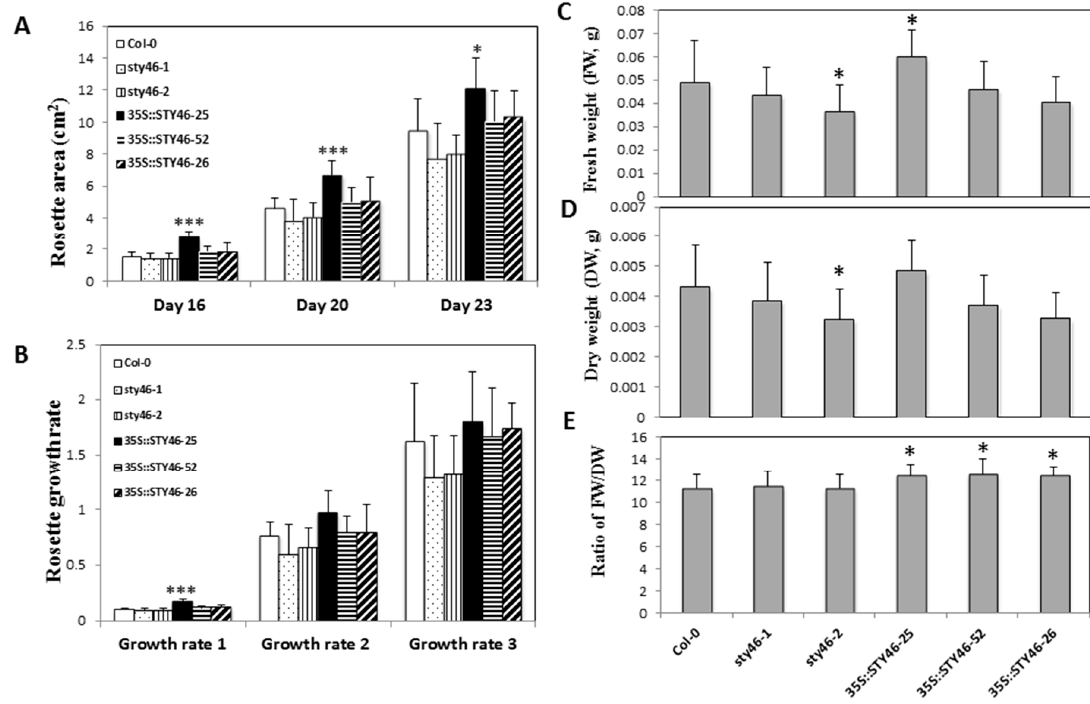
Figure 3. Change in rosette growth parameters. Rosette ( A ) surface area, ( B ) growth rate, ( C ) fresh weight (FW), ( D ) dry weight (DW), and ( E ) FW / DW, of STY46 transgenic genotypes. The rosette area was measured at 16 days, 20 days, and 23 days, respectively, and the growth rate during 0–16 days (growth rate 1), 16–20 days (growth rate 2), and 20–23 days (growth rate 3) was calculated. The asterisks in ( A , B ) indicate the statistically significant di ff erences between transgenic lines and the wild type control ( n = 12, ‘*’, 0.01 < p < 0.05; ‘**’, 0.001 < p < 0.01; ‘***’, 0 < p < 0.001). The asterisks in ( C – E ) indicate the statistically significant di ff erences between transgenic lines and the wild type control ( n = 16, p < 0.05).